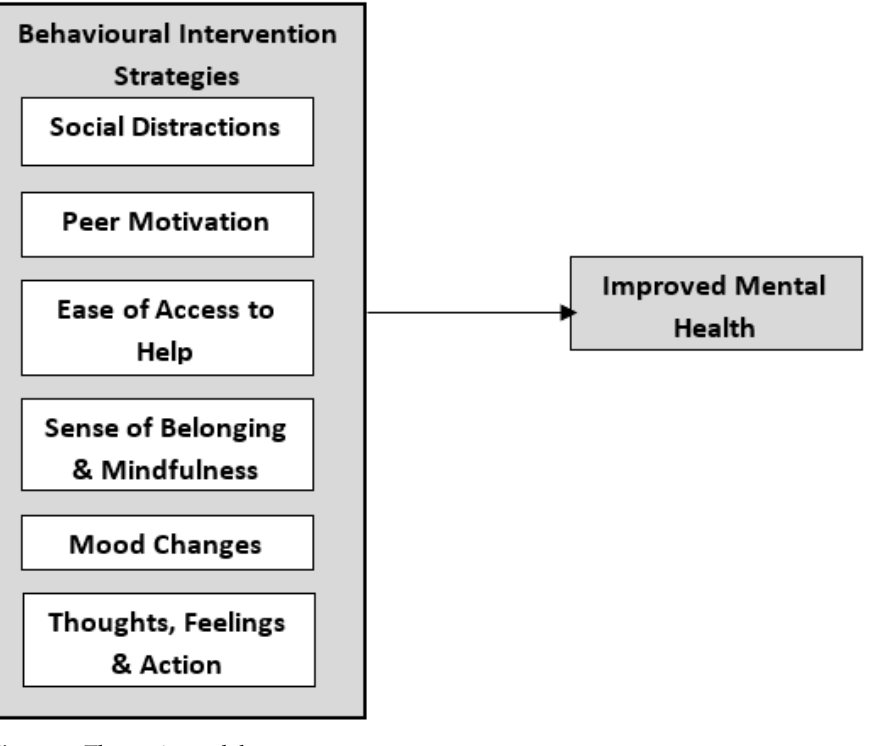
Figure 1. Theoretic